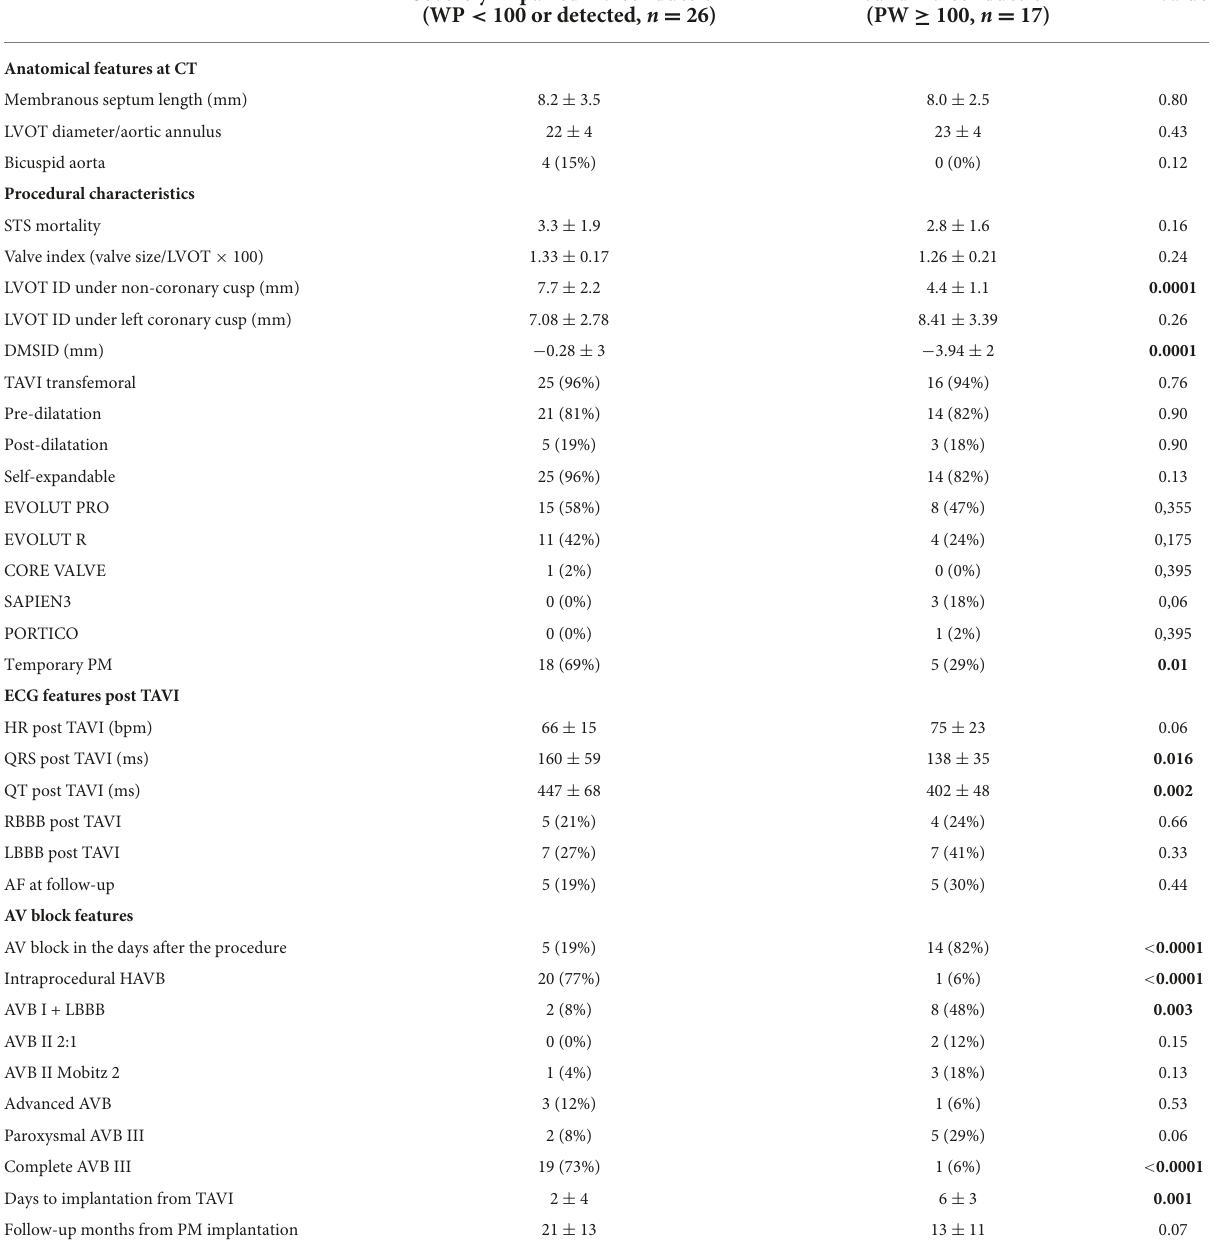
TABLE 2 Anatomical, procedural and follow-up